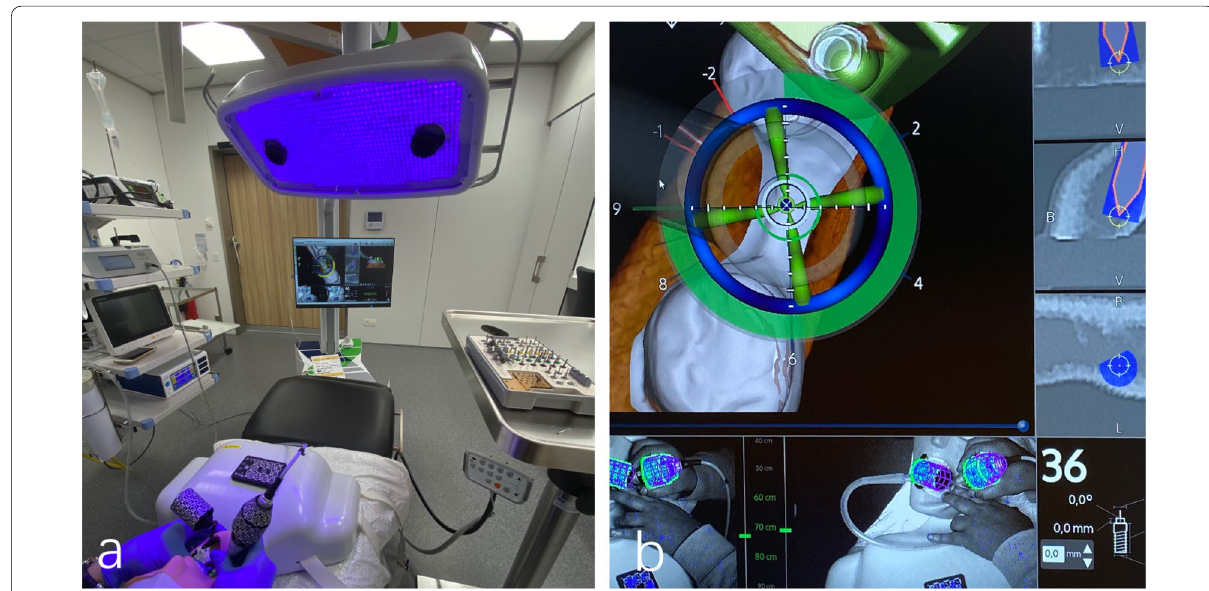
Fig. 2 Navigation surgery. a Navigation system overview. b Screen displays implant site